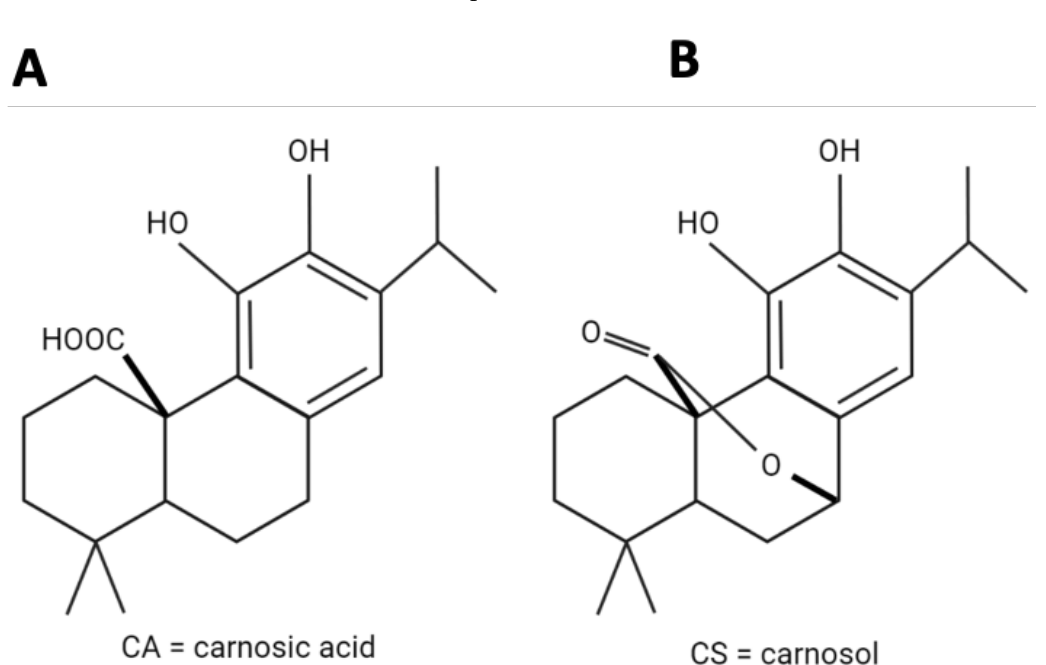
Figure 1. Chemical structures of ( A ) Carnosic acid (MW: 332.43 g/mol) and ( B ) Carnosol (MW: 330.42